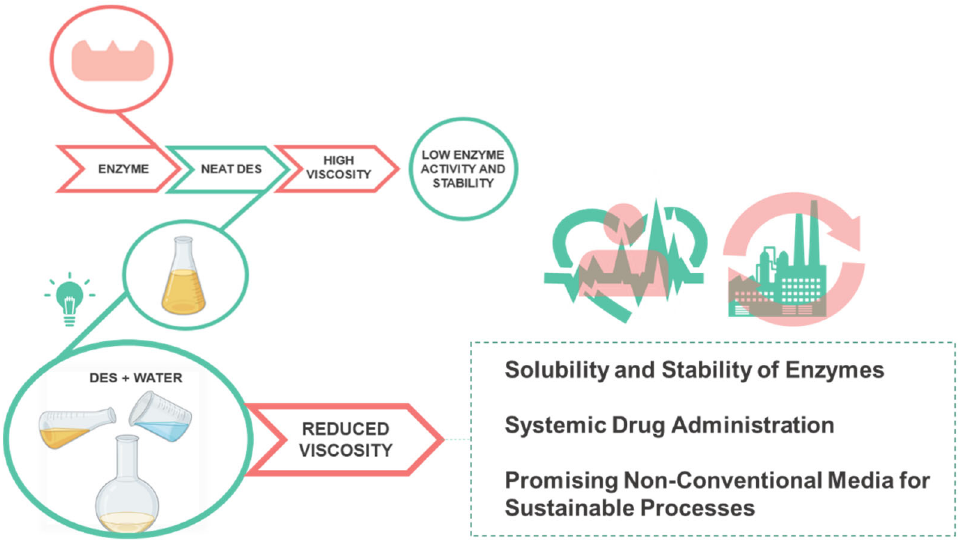
Figure 5. Scheme representing the main properties and advantages of hydrated deep eutectic solvents for the stability of enzymes.